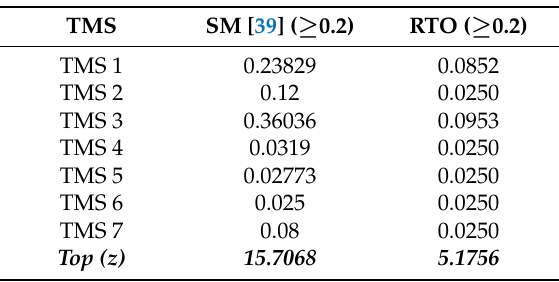
Table 12. Optimal TMS for Case